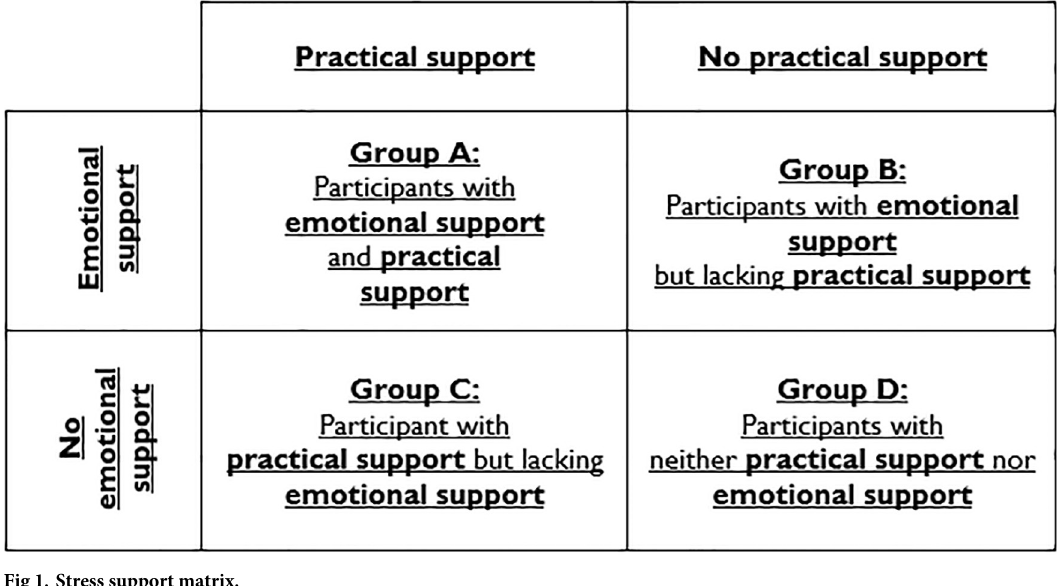
Fig 1. Stress support